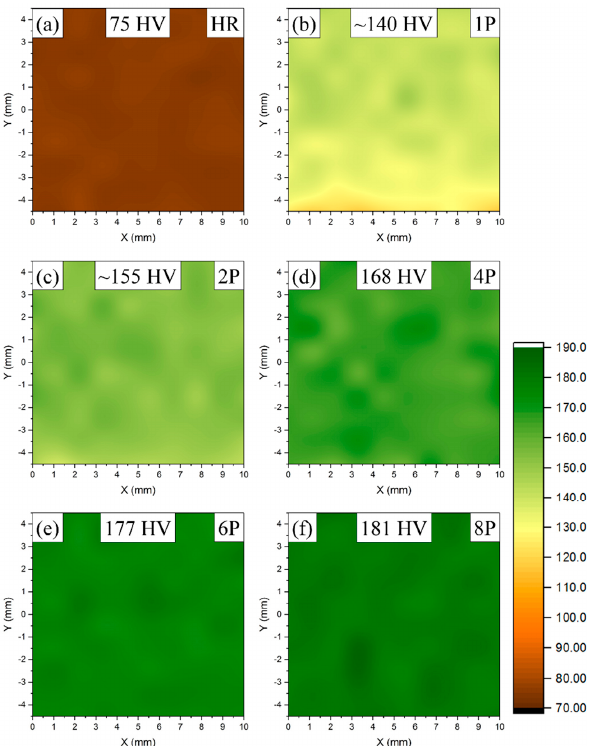
Figure 2. Color-coded contour maps of the hardness on the longitudinal section of the Cu-Mg alloy ( a ) before the ECAP process and after ( b ) 1, ( c ) 2, ( d ) 4, ( e ) 6 and ( f ) 8 ECAP passes. Crystals 2020 , 10 , x FOR PEER REVIEW